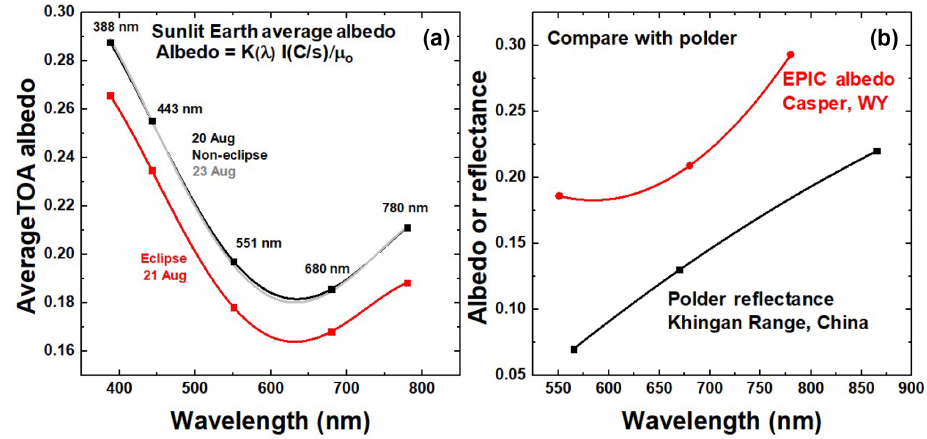
Figure 11. (a) The measured albedo at Casper, Wyoming, on 20 August (black curve) and 23 August (gray curve) compared to (b) the POLDER-measured surface reflectance in the Khingan Range, China (Maignan et al., 2004), corresponding to 8 ◦ from overhead